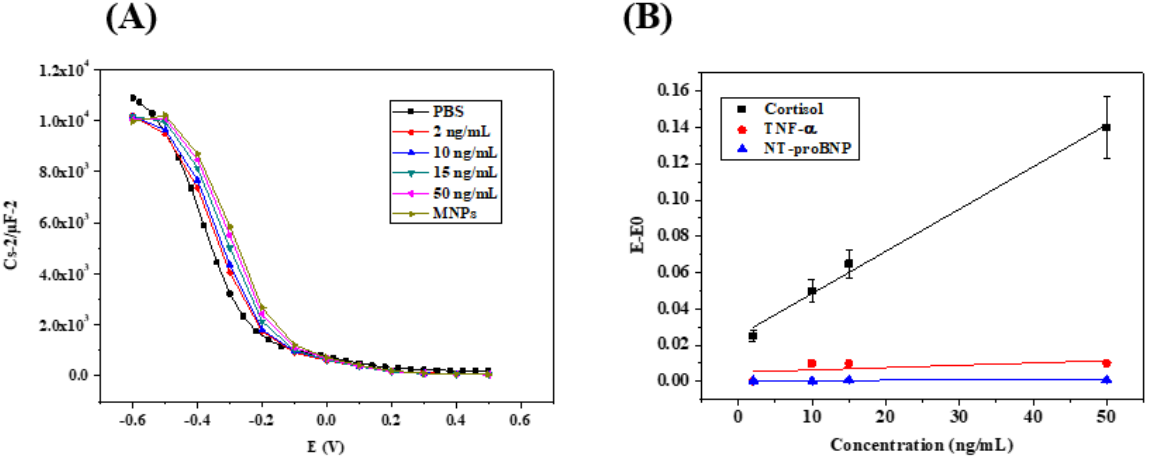
Figure 9. ( A ) Capacitance–voltage plots for cortisol detection using the capacitance biosensor; ( B ) the calibration curves of the cortisol detection (black curve) and the two interferences: TNF- α (red curve) and NT-proBNP (blue curve).